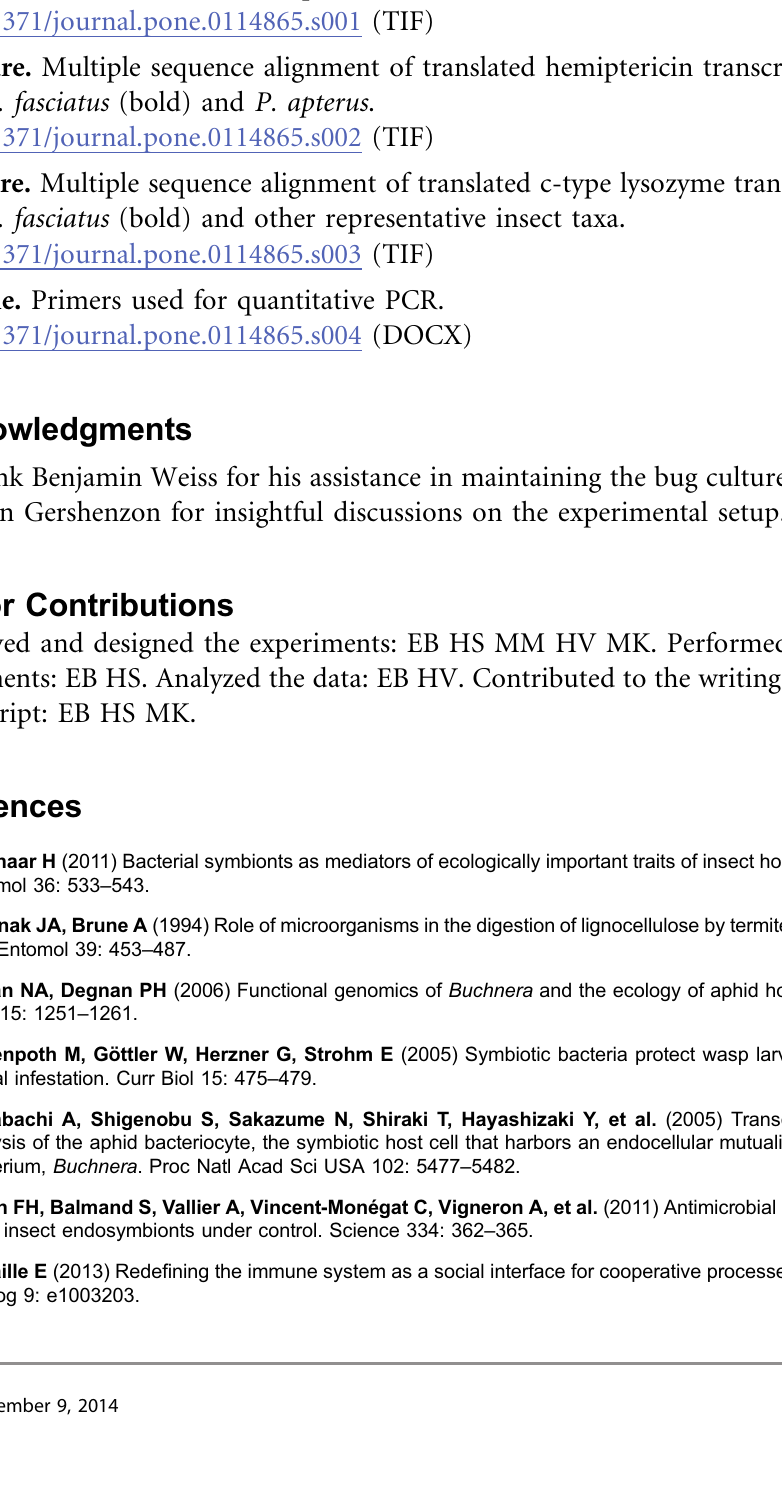
S1 Figure. Multiple sequence alignment of translated defensin transcripts from D. fasciatus (bold) and other Heteroptera. S2 Figure. Multiple sequence alignment of translated hemiptericin transcripts from D. fasciatus (bold) and P. apterus . S3 Figure. Multiple sequence alignment of translated c-type lysozyme transcripts from D. fasciatus (bold) and other representative insect taxa. S1 Table. Primers used for quantitative